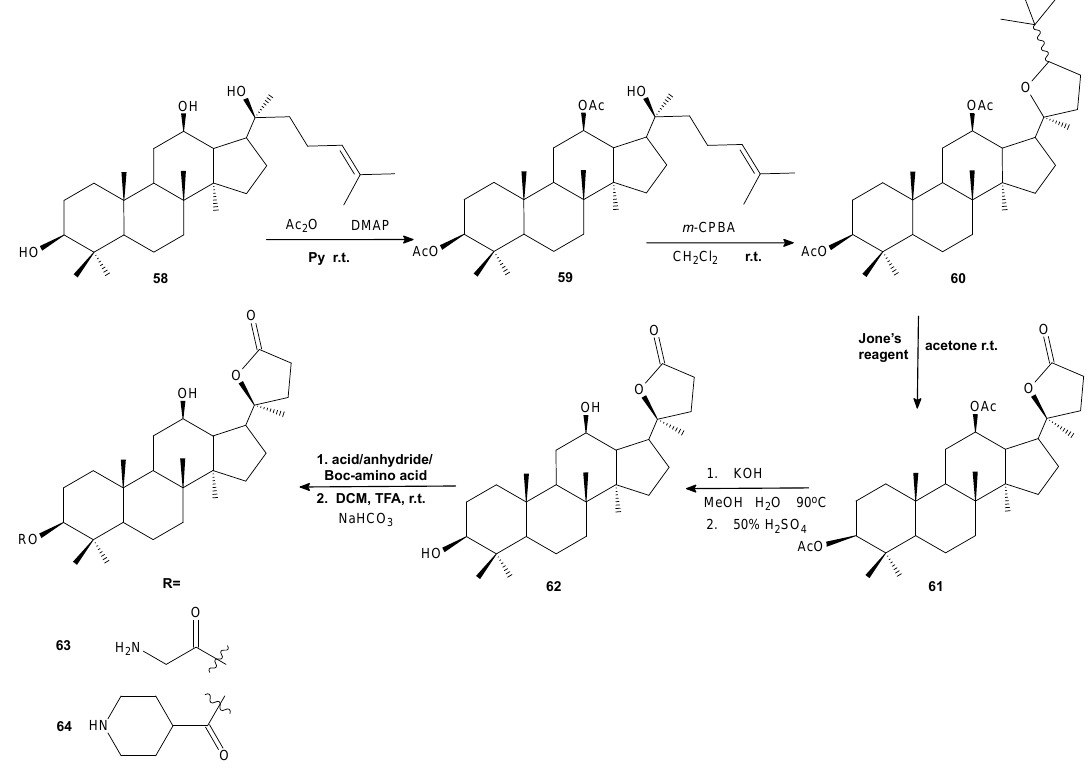
Figure 7. The synthesis of lactones 63 and 64 .